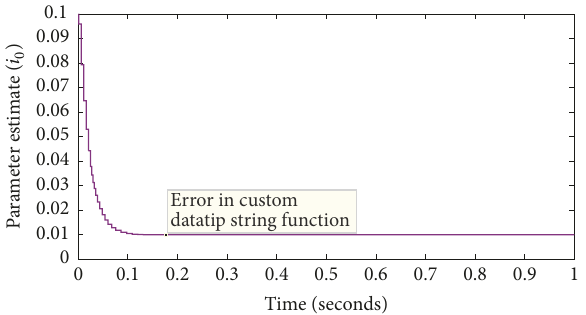
Figure 20: Time history of parameter